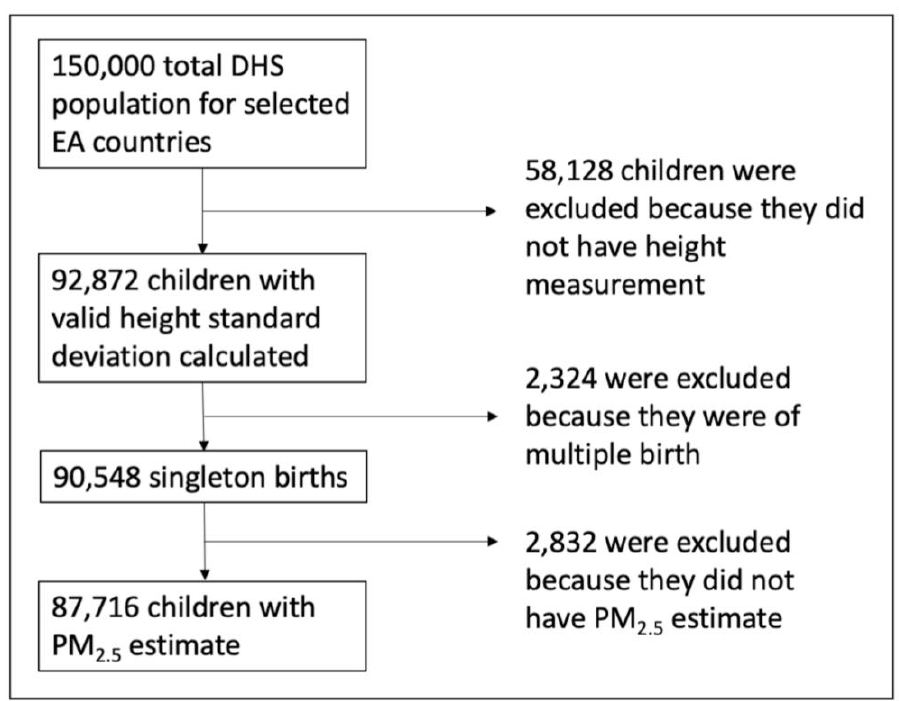
Figure 1. Schematic diagram of the inclusion criteria for the final sample size.